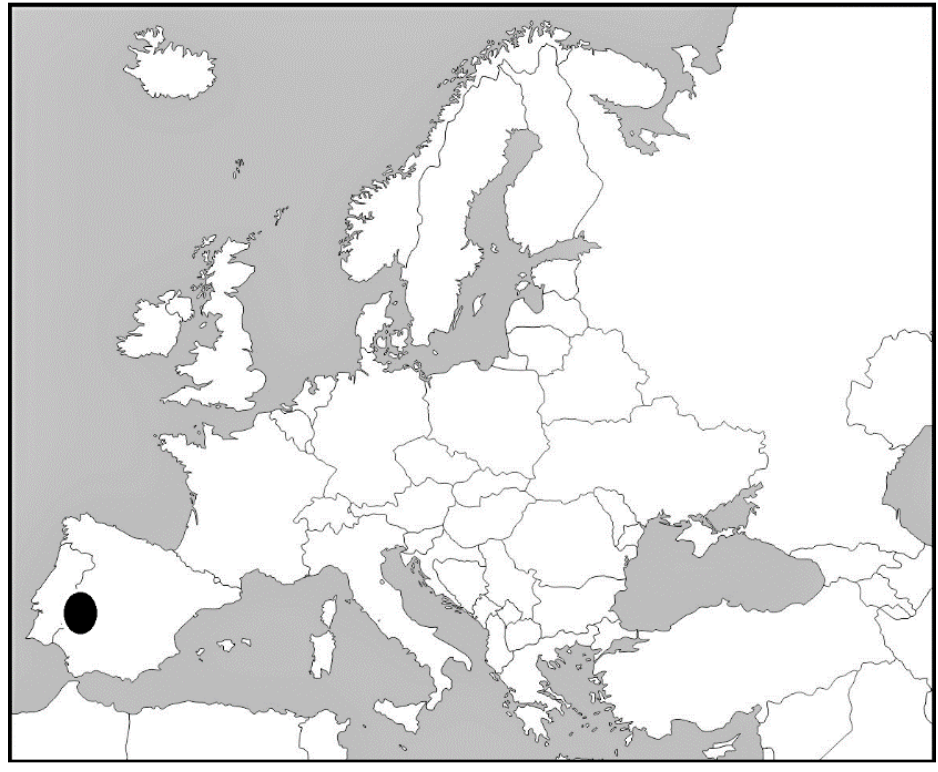
Figure 1. Extremadura in